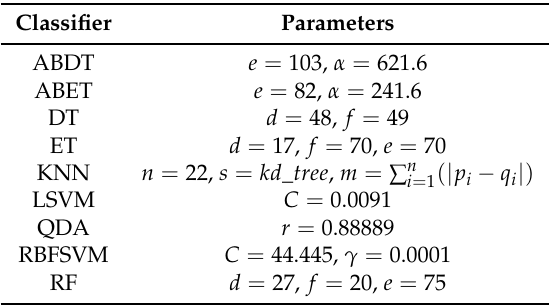
Table 3. Optimal classifier parameters ( α : learning rate; n : number of neighbors; e : number of estimators; s : search algorithm; d : max depth; m : metric between point p and q ; f : max number of features; r : regularization parameter).